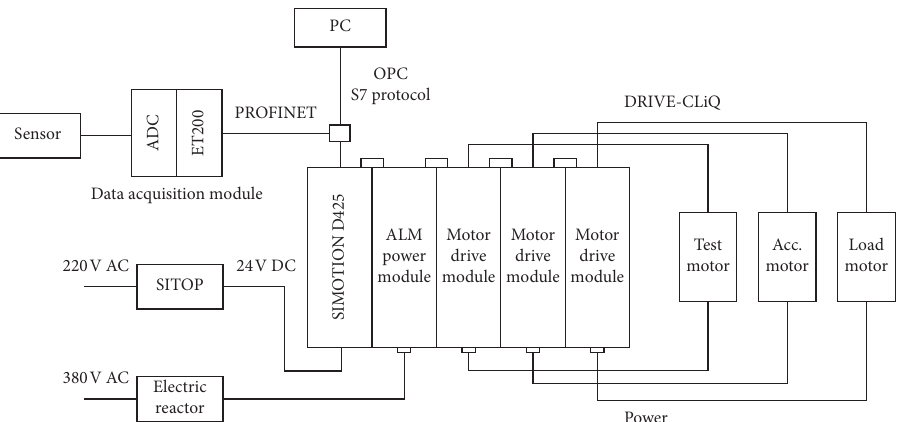
Figure 10: Testing machine hardware system composition block.